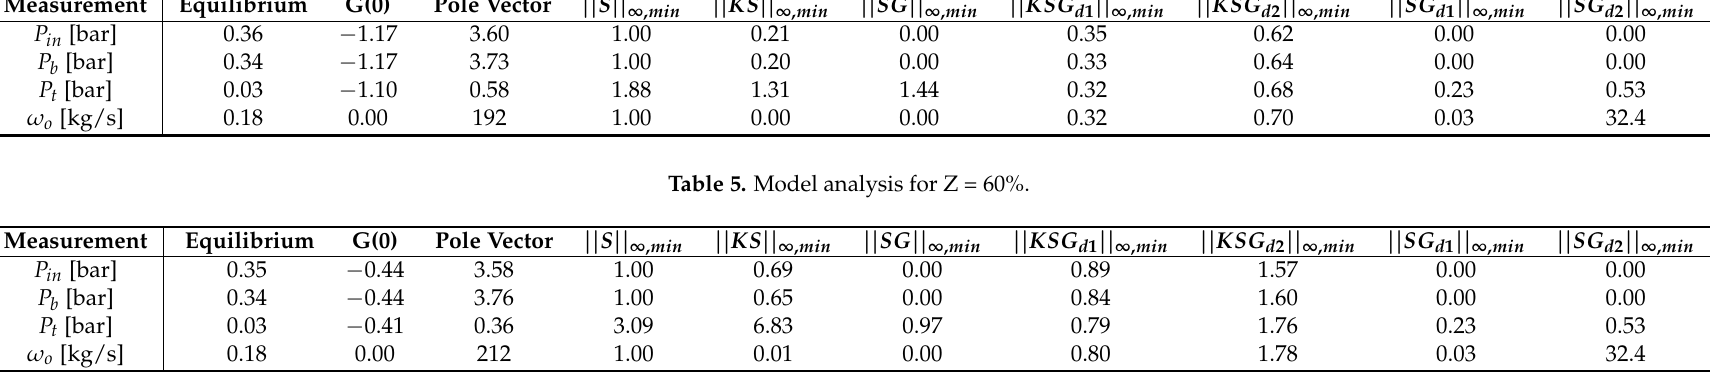
Table 6. Model analysis for Z =